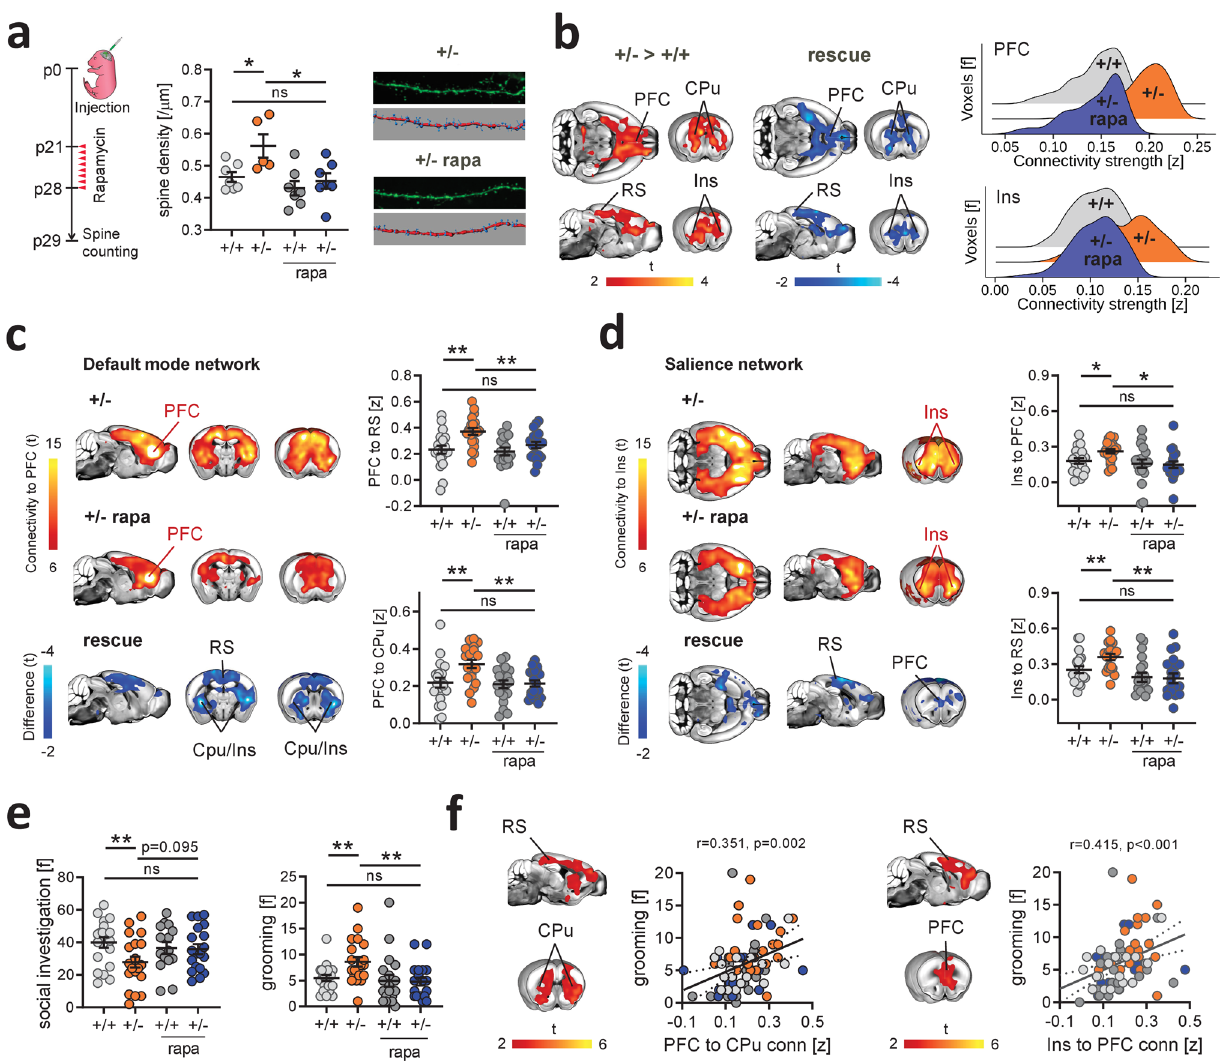
Fig. 3 Pharmacological mTOR inhibition rescues synaptic surplus, functional hyperconnectivity, and autism-like behavior in Tsc2 + / − mice. a Experimental design of spine density measurements (left). Developmental treatment with the mTOR inhibitor rapamycin normalized dendritic spine density in rapamycin-treated Tsc2 + / − mice ( + / − rapa) to the level of vehicle-treated Tsc2 + / + control mice ( + / + ). n = 7 mice ( + / + , + / − rapa, and + / + rapa) and n = 5 mice ( + / − ). b Voxelwise rsfMRI mapping showed a pattern of decreased long-range functional connectivity in rapamycin-treated Tsc2 + / − mice (blue), recapitulating the anatomical regions showing increased rsfMRI connectivity in Tsc2 + / − mice (red – yellow coloring, left). Rescue here denotes the effect of rapamycin in Tsc2 + / − mutants i.e., areas of decreased rsfMRI connectivity in rapamycin-treated vs. vehicle-treated Tsc2 + / − mice. Global histogram analysis con fi rmed the rescue of long-range hyperconnectivity in prefrontal and insular regions of rapamycin-treated mutants (right). c Spatial extension of the mouse default-mode network in the vehicle- (top) and rapamycin- (bottom) treated Tsc2 + / − mice. Between-group connectivity mapping and regional quanti fi cations revealed that treatment with rapamycin rescued prefrontal rsfMRI hyperconnectivity in Tsc2 + / − mice to levels comparable to control mice (right). n = 20 mice for each group. d Spatial extension of the salience network in the vehicle- (top) and rapamycin- (bottom) treated Tsc2 + / − mice. Rapamycin completely rescued salience network hyperconnectivity in rapamycin-treated Tsc2 + / − mice. Rescue in ( c ) and ( d ) denotes the effect of rapamycin in Tsc2 + / − mutants i.e., areas of decreased rsfMRI connectivity in rapamycin-treated vs. vehicle-treated Tsc2 + /- mice. n = 20 mice for each group. e Rapamycin also rescued altered self-grooming and social behaviors in Tsc2 + / − rapa mice. Grooming, mice, n = 20 ( + / + ), n = 20 ( + / − ), n = 19 ( + / + rapa), n = 19 ( + / − rapa). Social investigation, mice, n = 20 ( + / + ), n = 20 ( + / − ), n = 15 ( + / + rapa), n = 19 ( + / − rapa). f Voxelwise correlation mapping revealed a signi fi cant positive correlation between prefrontal (left, Pearson ’ s r , r = 0.351, P = 0.002) and insular (right, Pearson ’ s r , r = 0.415, P < 0.001) rsfMRI connectivity, and motor stereotypes. PFC prefrontal cortex, CPu striatum, RS retrosplenial cortex, Ins insular cortex. Scatterplots represent the quanti fi cation of these correlations in the striatum and PFC, respectively. * q < 0.05, ** q < 0.01, all FDR-corrected. Error bars represent SEM. Source data are provided as a Source Data fi speci fi city of our fi ndings, supporting a causal link between characterized by rsfMRI hyperconnectivity in vehicle-treated ASD-relevant mTOR-dependent synaptic pathology and rsfMRI Tsc2 + / − mutants (Fig. 3b). In keeping with this, rapamycin also hyperconnectivity in Tsc2 + / − mice. rescued default-mode network (Fig. 3c) and salience network To assess whether these connectivity fi ndings are behaviorally (Fig. 3d) rsfMRI connectivity in Tsc2 + / − -treated mice, as probed relevant, we next measured social behaviors and motor stereo- with prefrontal and anterior insular seed-based correlation ana- typies in rapamycin and vehicle-treated Tsc2 + / − mice using a lysis, respectively. These results corroborate the mechanistic